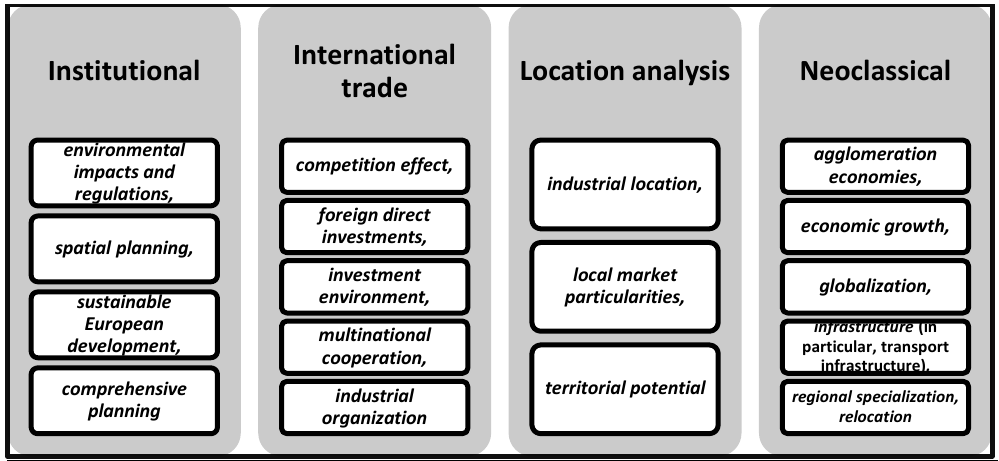
Fig. 1. Identification of the content of spatial economics: Indicators (factors, terms) per group of determinants [presentation of analysis made by